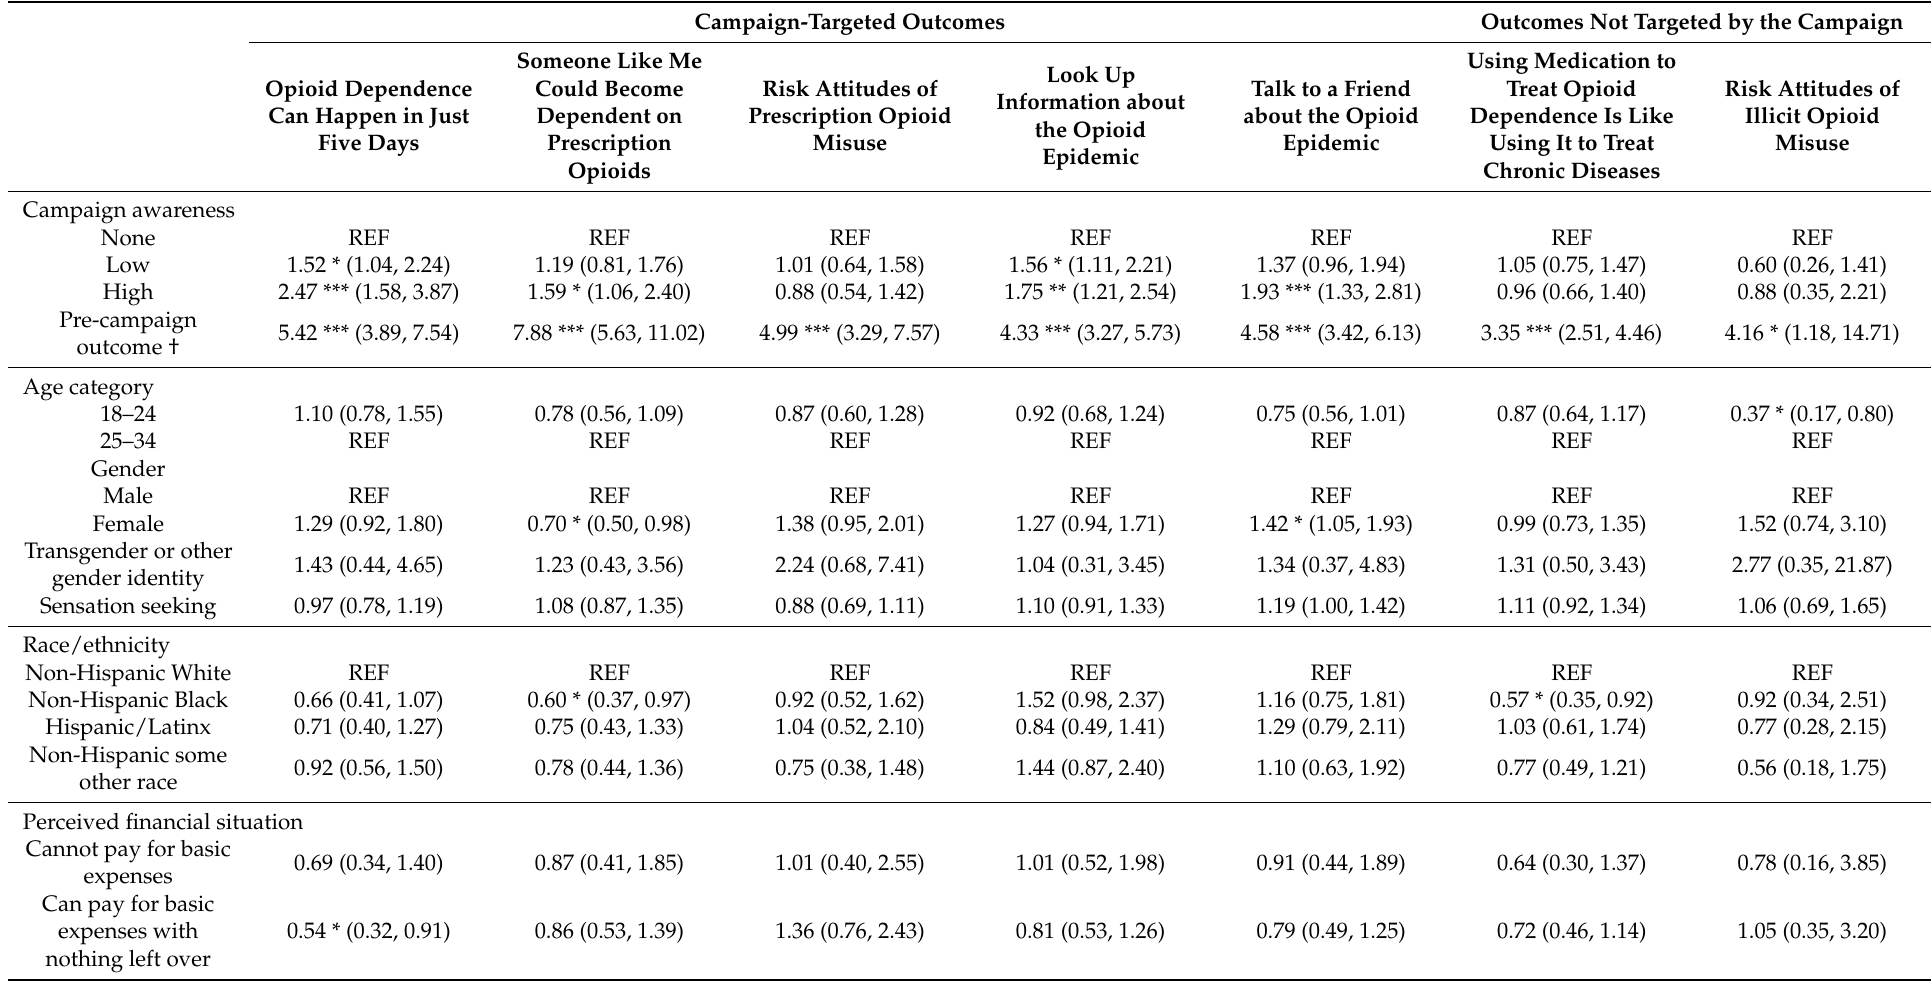
Table 3. Results of logistic regression models examining association between campaign awareness and opioid knowledge, attitudes, and beliefs, controlling for DMA. Campaign-Targeted Outcomes Outcomes Not Targeted by the Campaign Someone Like Me Using Medication to Look Up Risk Attitudes of Opioid Dependence Could Become Risk Attitudes of Talk to a Friend Treat Opioid Information about Dependent on Prescription Opioid about the Opioid Dependence Is Like Illicit Opioid the Opioid Five Days Prescription Misuse Epidemic Using It to Treat Epidemic Opioids Chronic Diseases